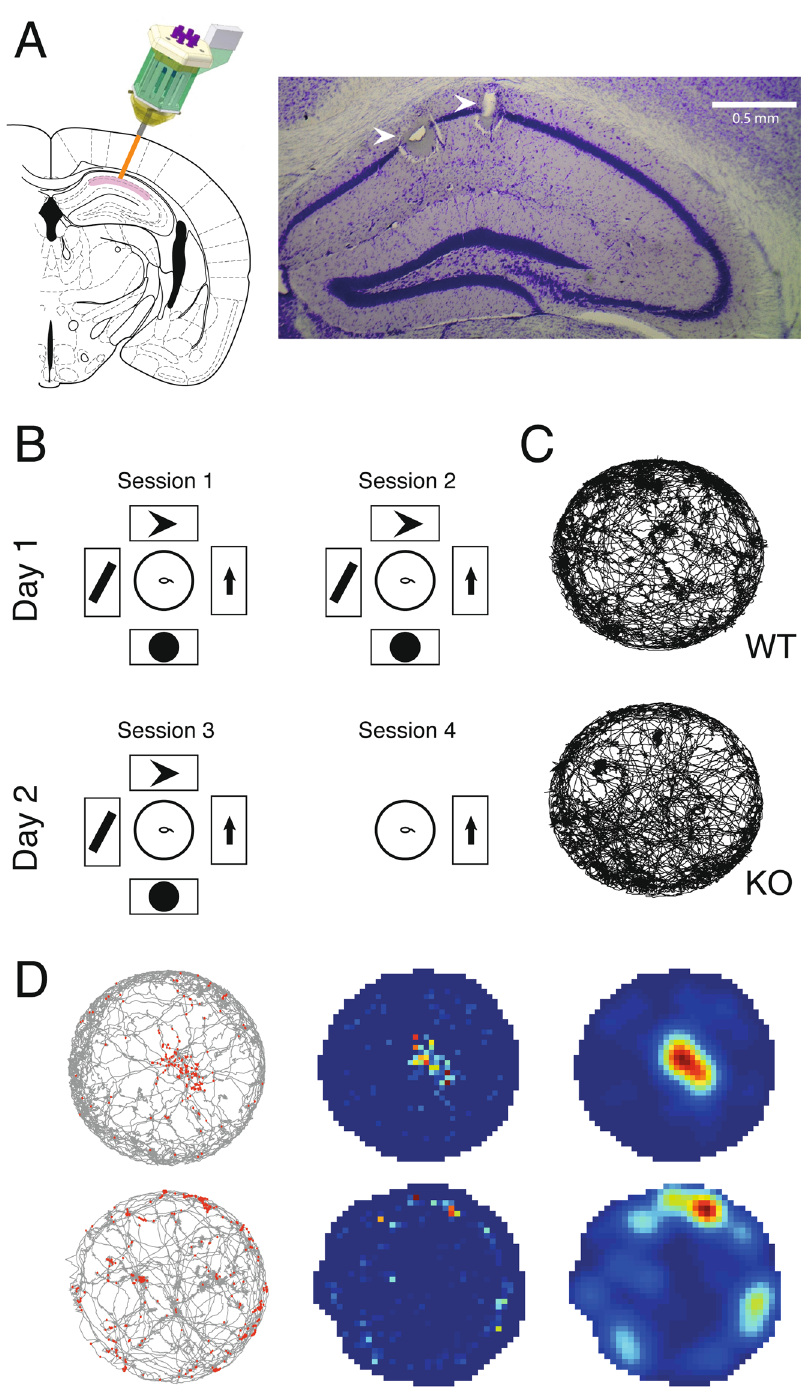
Figure 1. Experimental Setup. ( A ) Histology. Left, schematic of microdrive implantation target, modified from 50 . Right, coronal section showing the recording locations of two tetrodes in dorsal hippocampus CA1 (arrowheads). ( B ) Schematic of the behavioral protocol. On two consecutive days, in two sessions per day, animals freely explored a circular open field arena (middle). The arena was surrounded by four posters of geometric figures in the first three sessions, and only one poster in the fourth session. ( C ) Behavior. Accumulated trajectories of a WT and a KO animal exploring the arena during an example session. ( D ) Illustration of the three steps of firing map construction, for an example WT place cell (top row) and an example KO place cell (bottom row). Left, accumulated trajectory of animal exploration during the session, with spikes recorded from a single pyramidal cell superimposed in red. Middle, heat map of these spikes created by binning and normalizing this data. Right, smoothed heat map of these binned and normalized